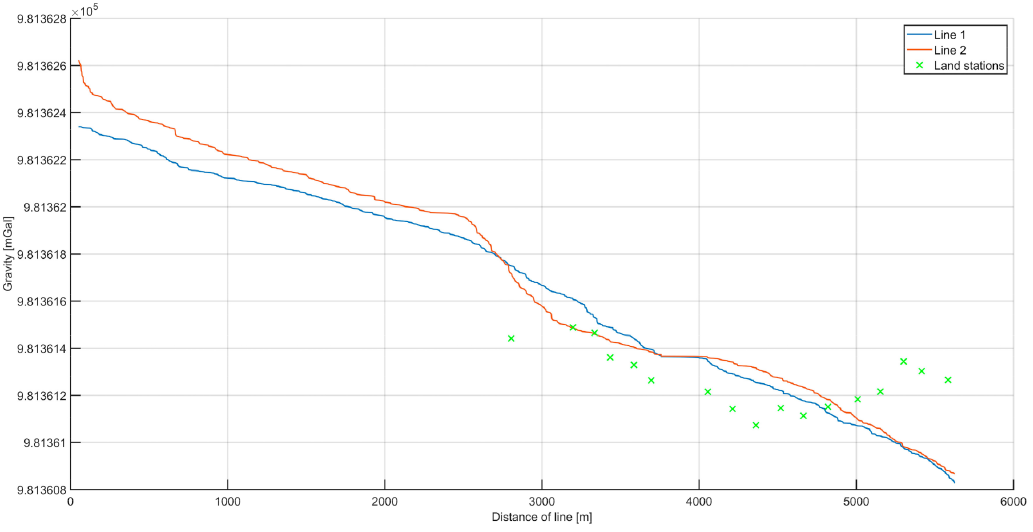
Figure 12. The superimposed values of gravitational acceleration on the two survey lines. In addition, land measurement points are marked, with the obtained values reduced to the height of the dynamic gravimeter. The data presented were processed as a result of the 20 Hz